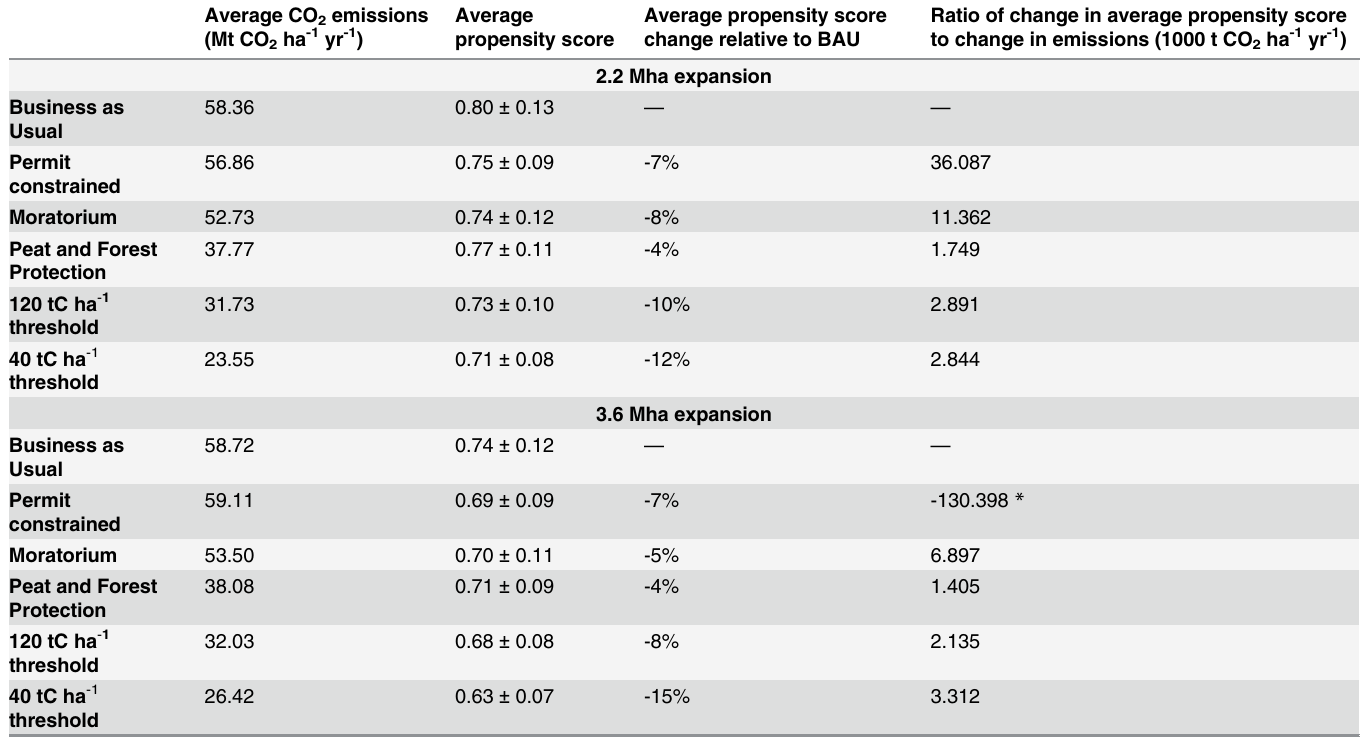
Table 3. Average propensity scores within areas of predicted